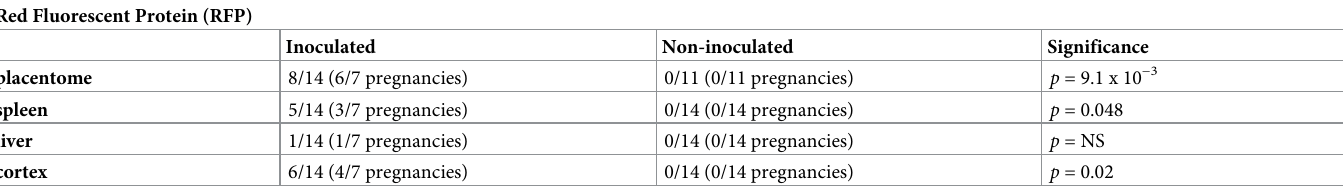
Table 4. PCR amplification of plasmid DNA encoding Red Fluorescent Protein (RFP). Data representation and statistical analysis are as described in Table 3.